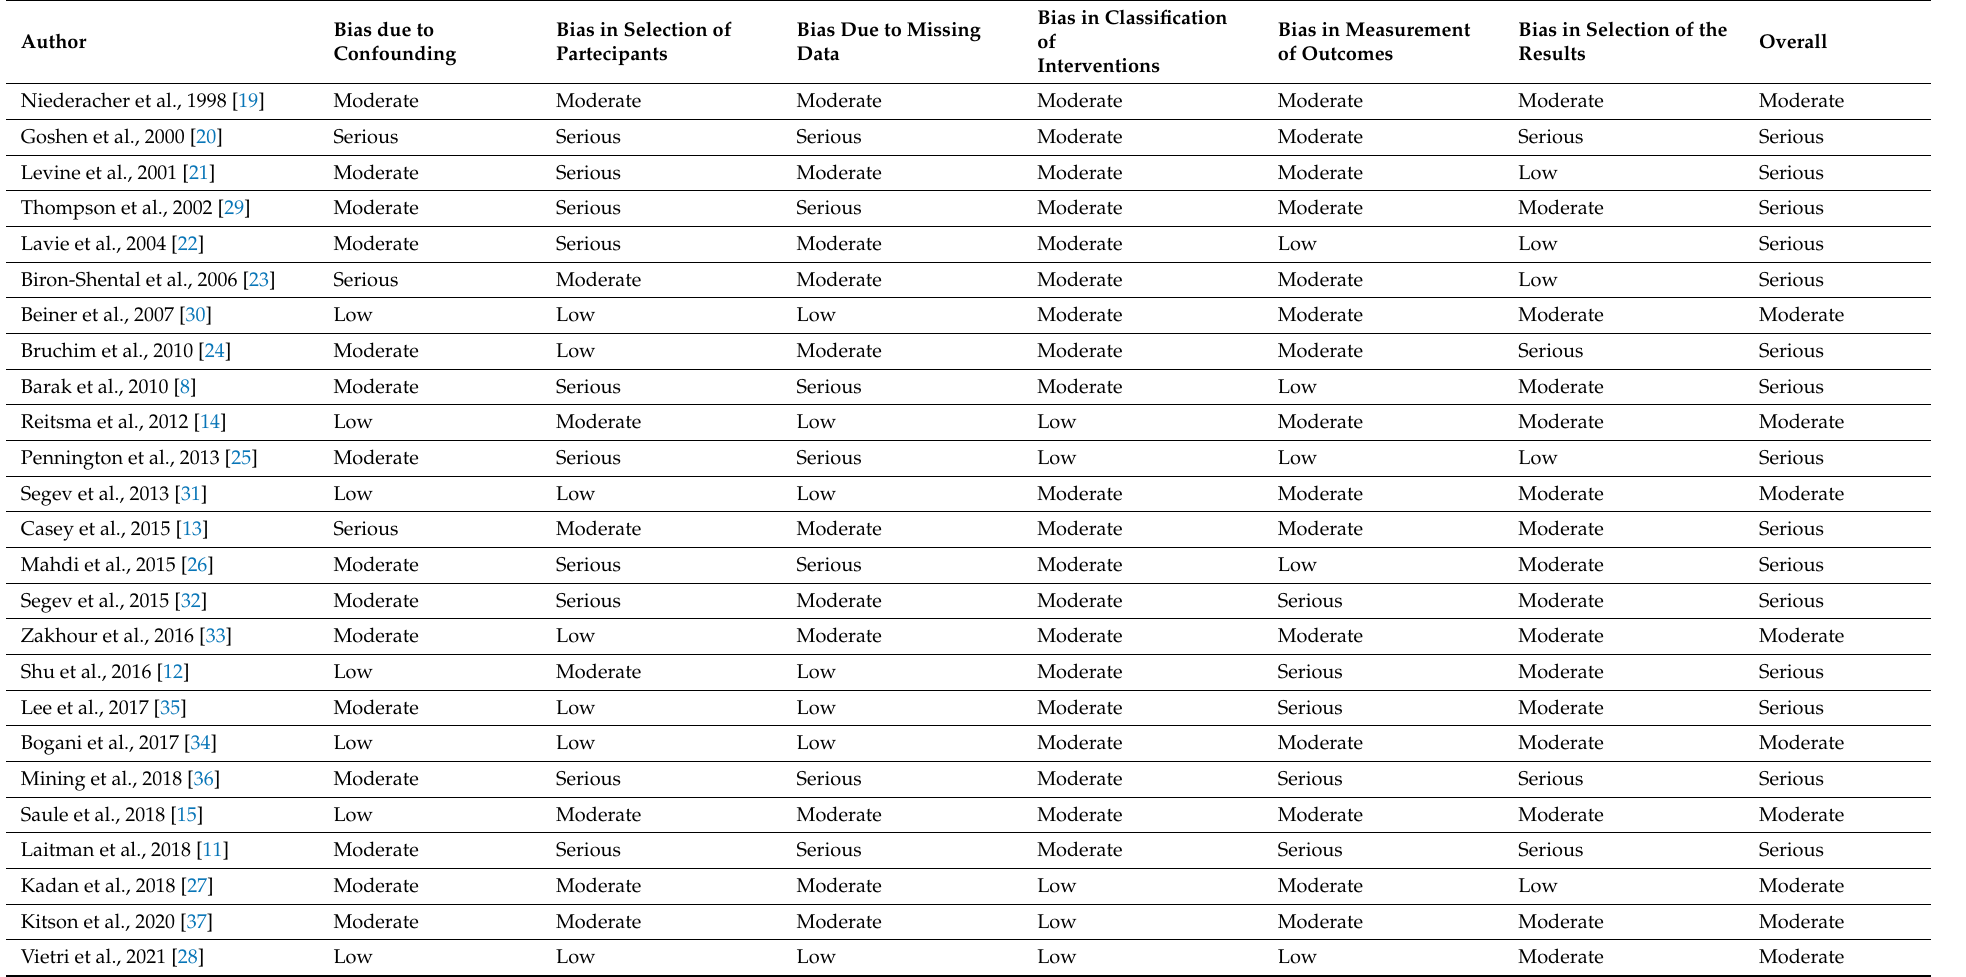
Table 3. Quality assessment of individual